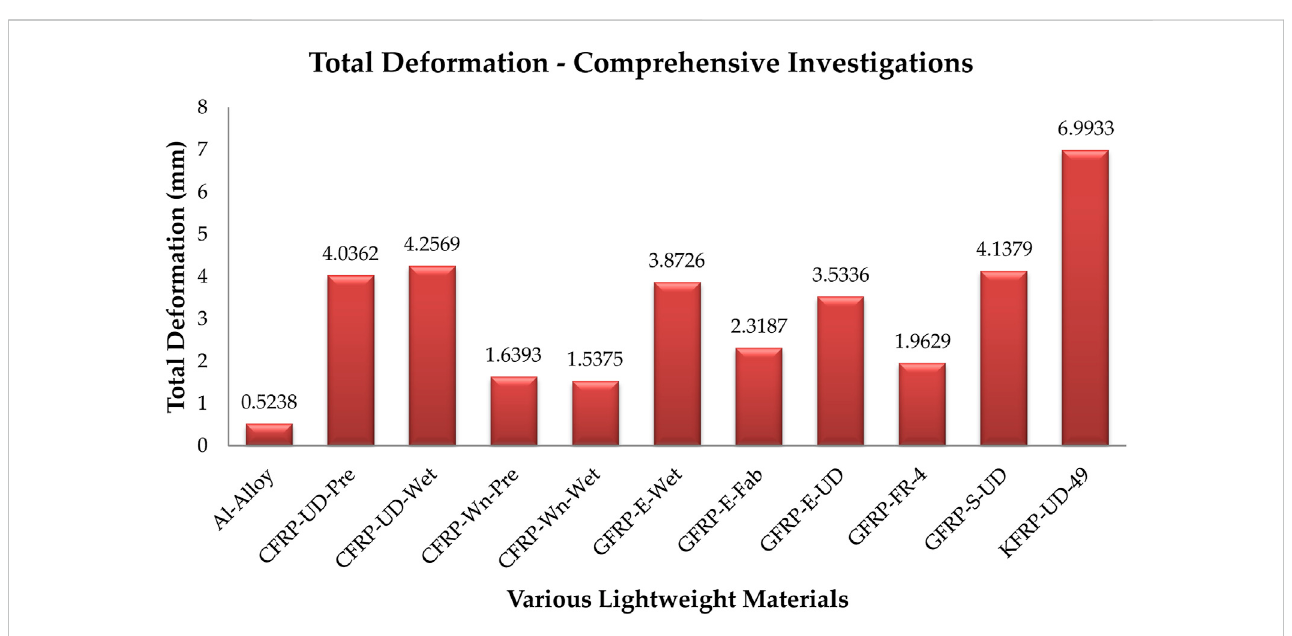
Comprehensive report of total deformation of